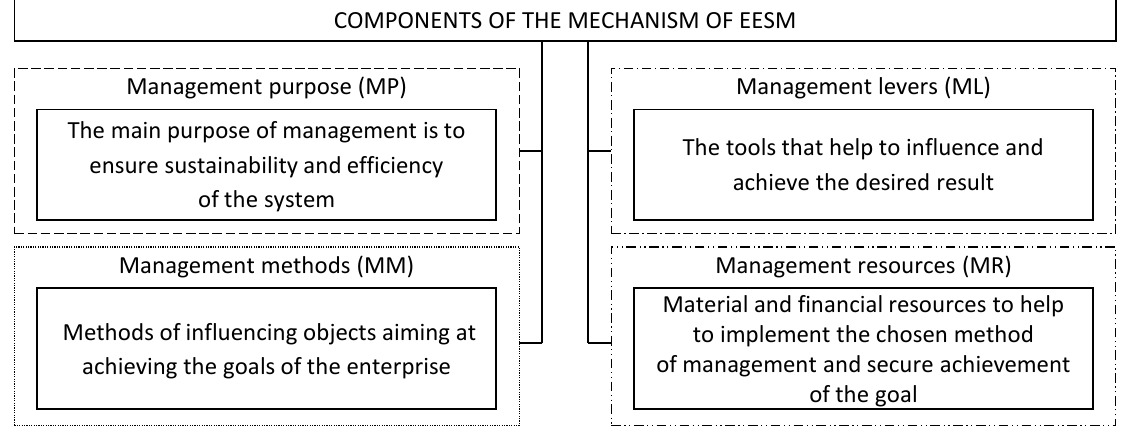
Figure 3. The set of the main components of the